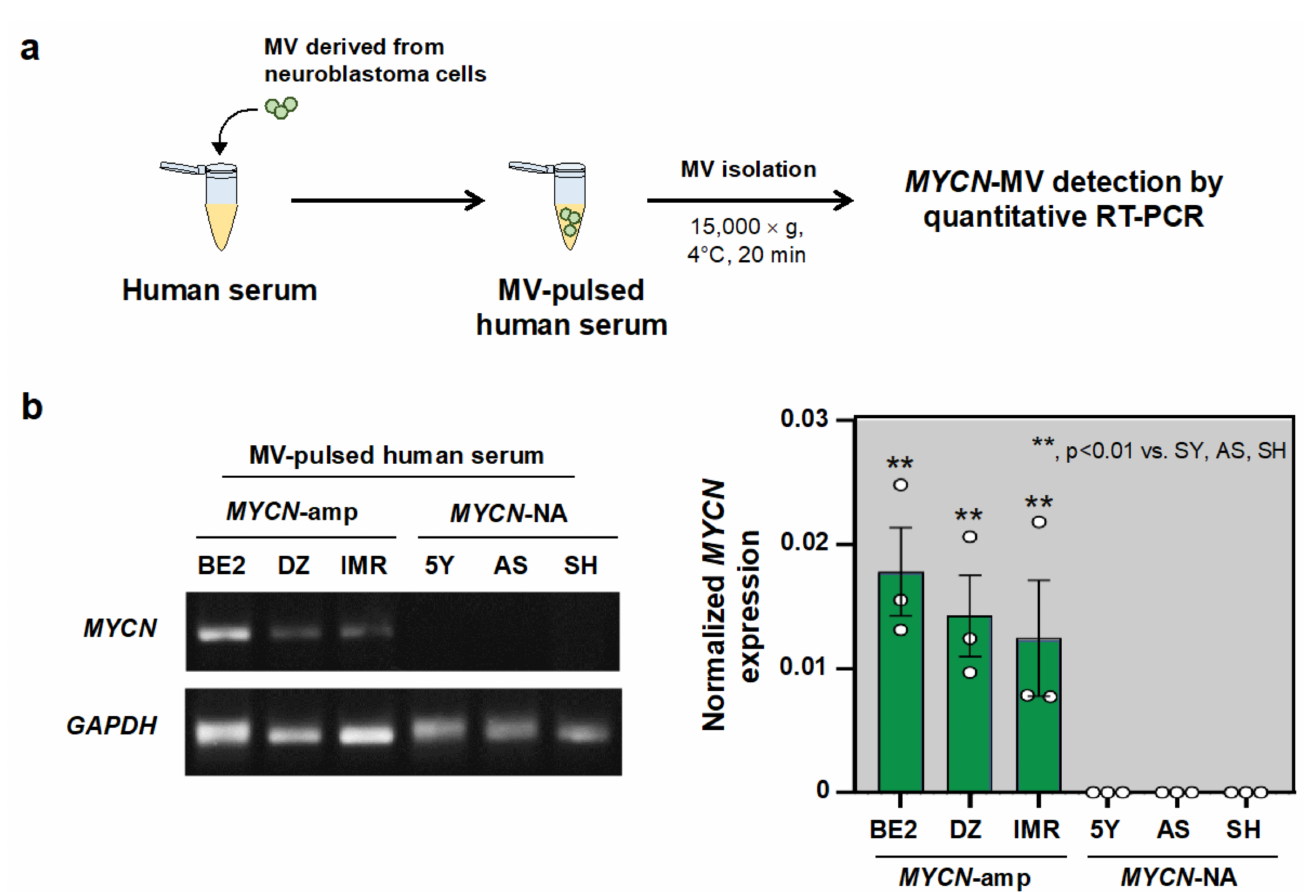
Figure 3. MYCN-MV detection in the simulated serum specimens. ( a ) A schematic diagram represents the workflow of simulated sample generation by pulsing MVs derived from NB cells into the human serum. Three simulated serum samples were generated independently as per the NB cell